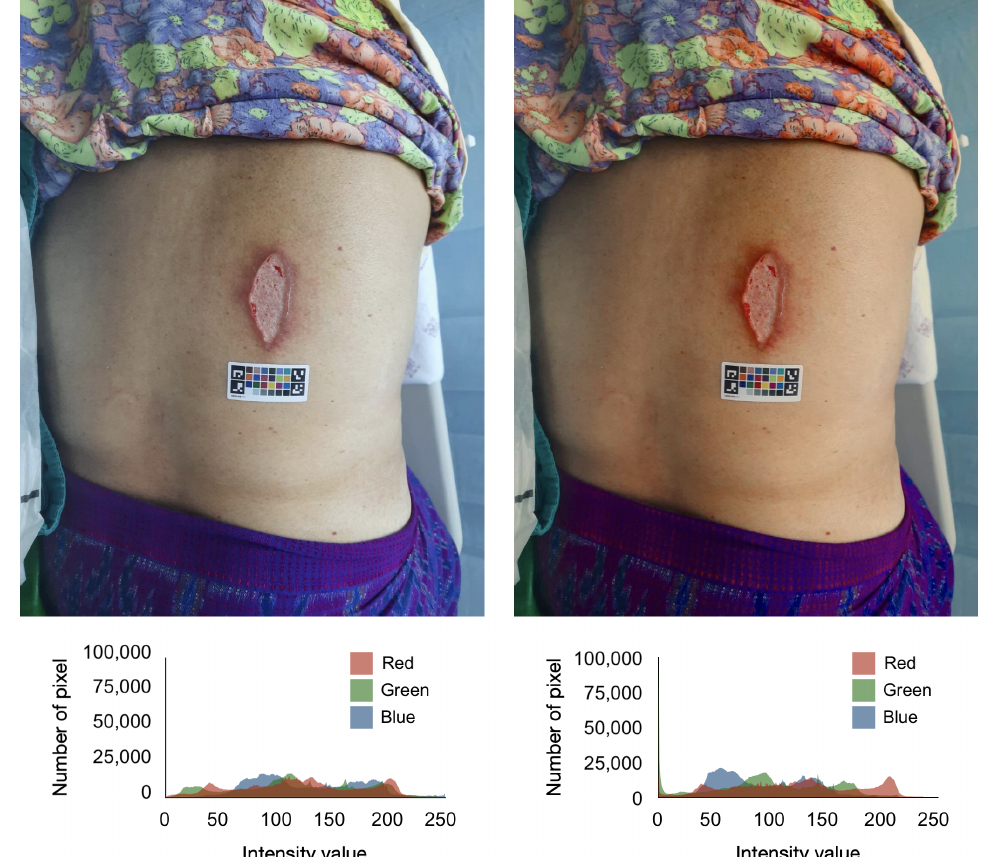
Figure 6. Comparison of the same wound image before and after color